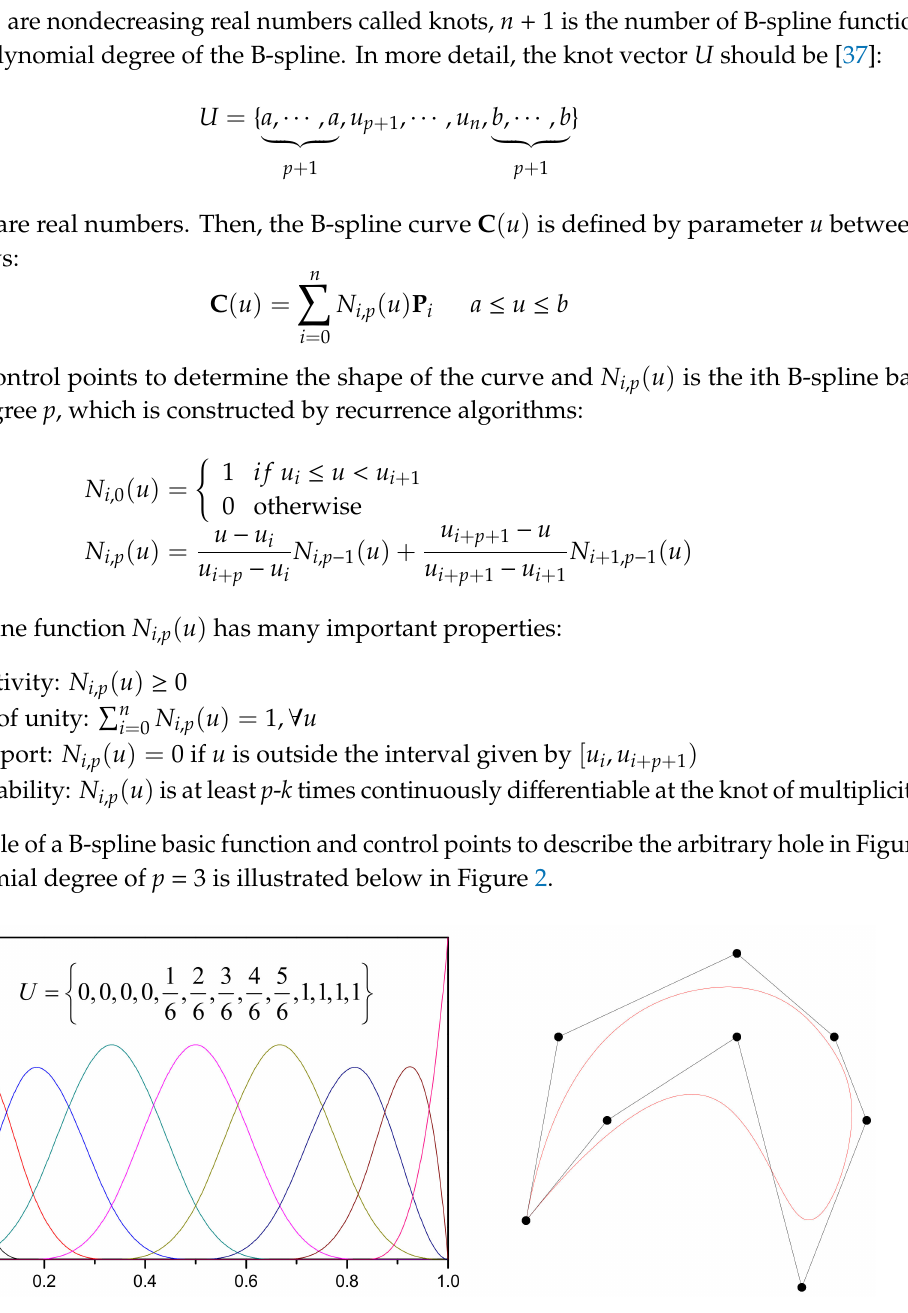
Figure 2. Example of a B-spline basic function and control points (black solid